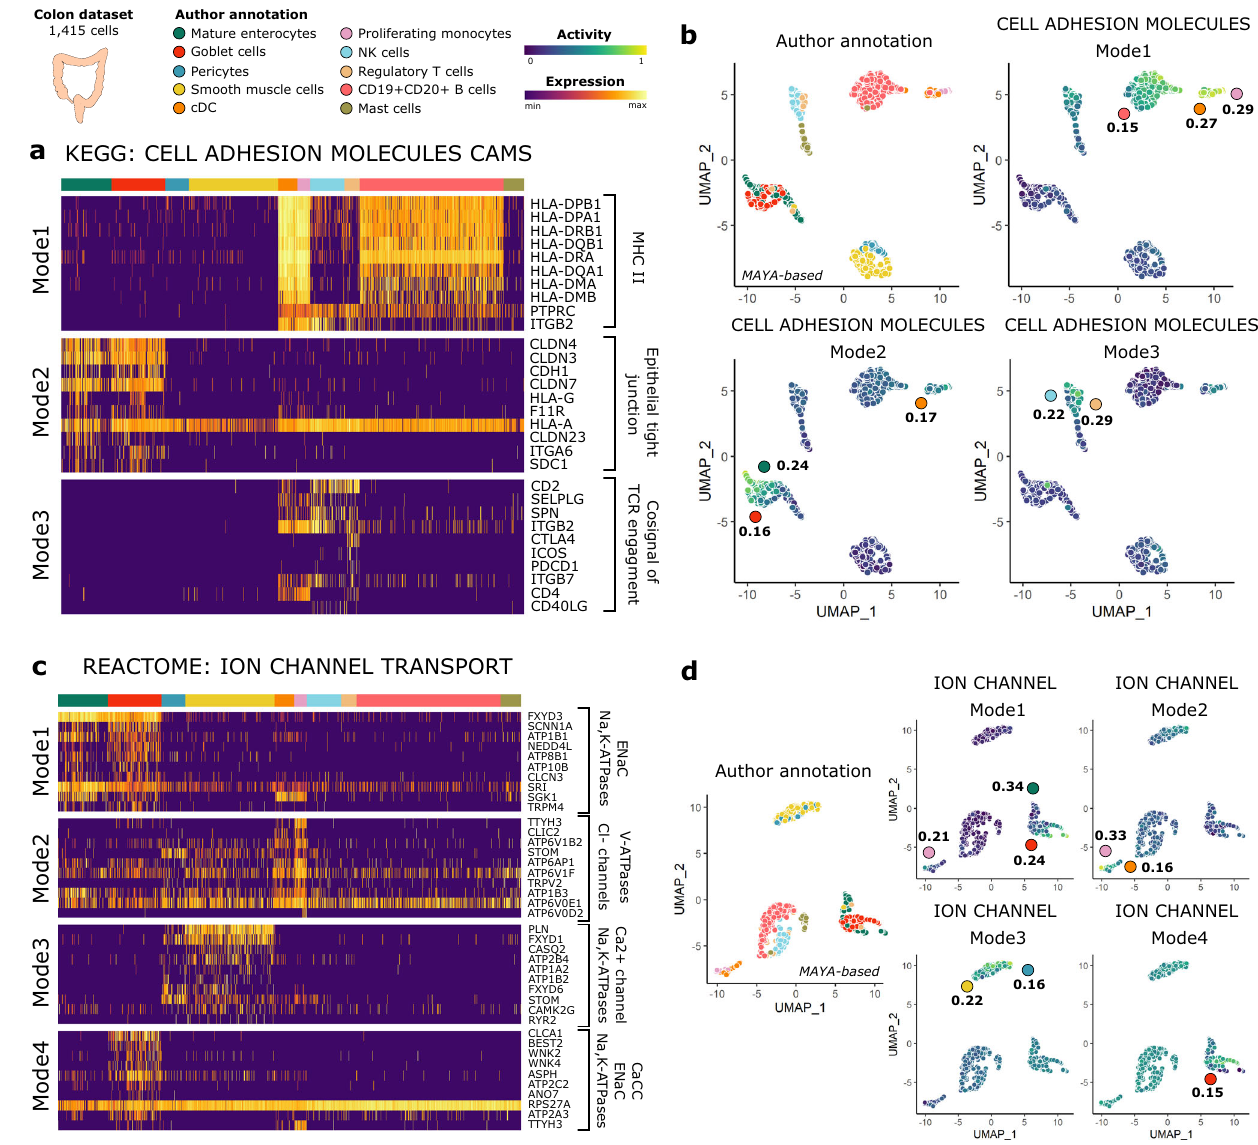
Fig. 3 | KEGGand REACTOME activityin colonwith MAYA. a Heatmap of scaled gene expression for top10 contributing genes for the three activation modes of KEGG Cell Adhesion Molecules pathway, ordered by decreasing contribution. b UMAP representation of activity matrix of KEGG pathways, cells are colored according to author annotation, or activity scores of the three modes of Cell AdhesionMoleculespathway.Speci fi cityscoreofcellpopulationsisdisplayednext